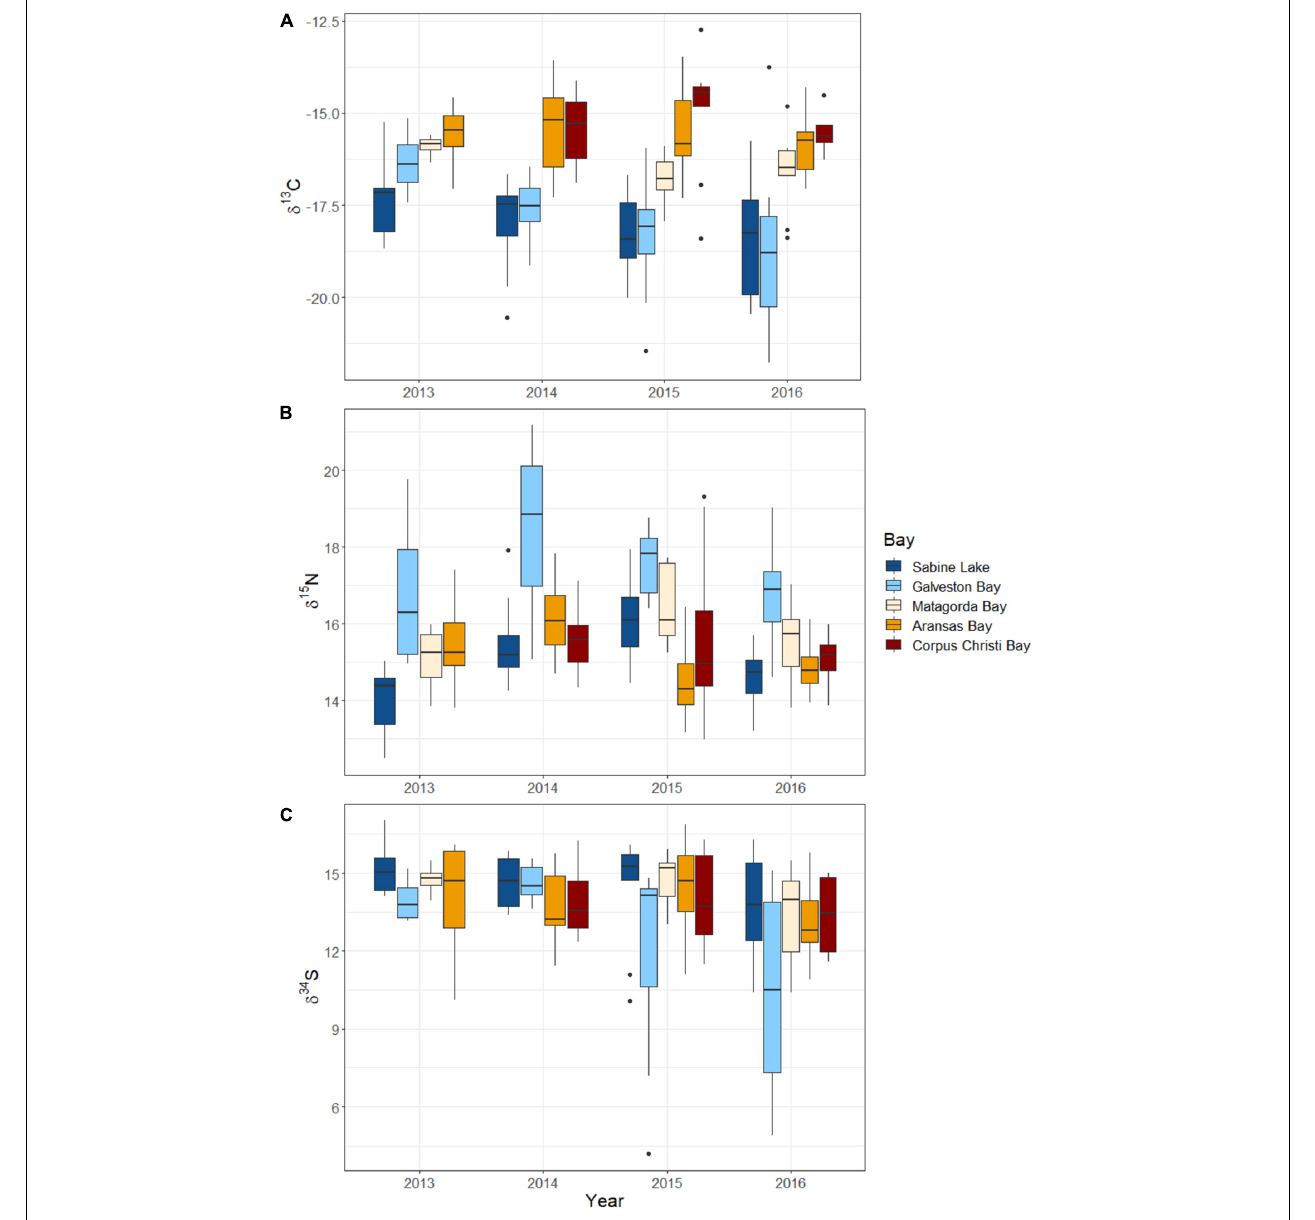
FIGURE 4 | Boxplots of stable isotope (A) δ 13 C, (B) δ 15 N, (C) δ 34 S delta values from juvenile bull sharks collected from estuaries (indicated by box shading) in the nwGoM between 2013 and 2016. Horizontal bars in each box represent median values, box margins represent the first and third quartiles, and whiskers approximate the 95% confidence interval of